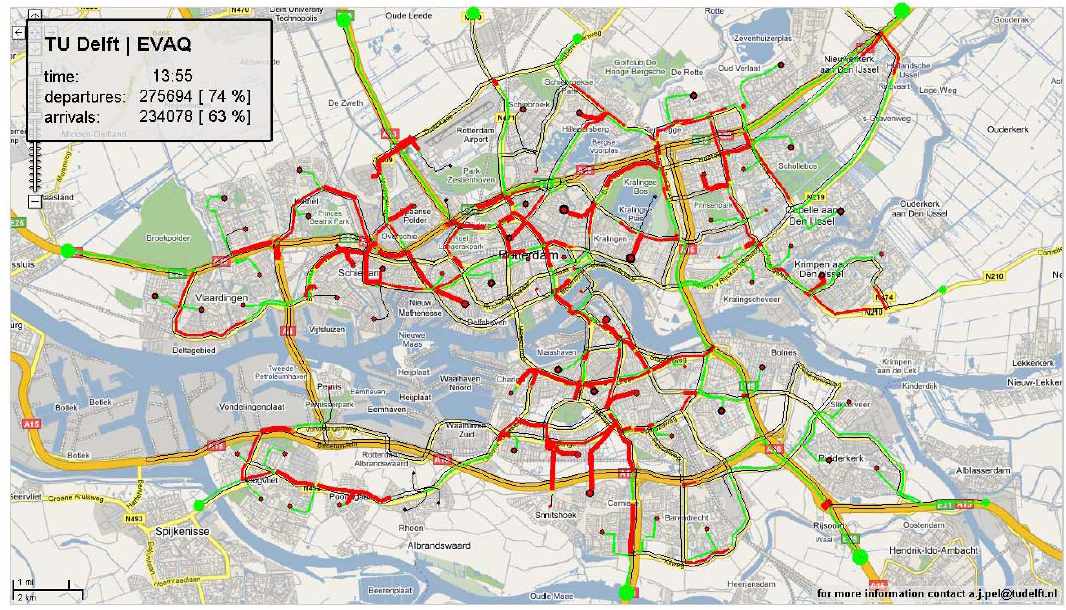
Figure 12. Rotterdam evacuation network ( Source: Google Maps) In other studies, the model is used as prediction model to optimize evacuation instructions. Optimization search methods have proven to substantially improve evacuation clearance times compared to evacuation by straightforward rules (such as evacuating towards the nearest exit, using the shortest routes, and spreading departure times to avoid the occurrence of congestion) (Huibregtse et al. 2009). More interestingly, the inclusion of traveller compliance in the model formulation has also been exploited to extend such an optimization method to design efficient evacuation instructions which anticipate this level of partial traveller compliance (Pel et al.